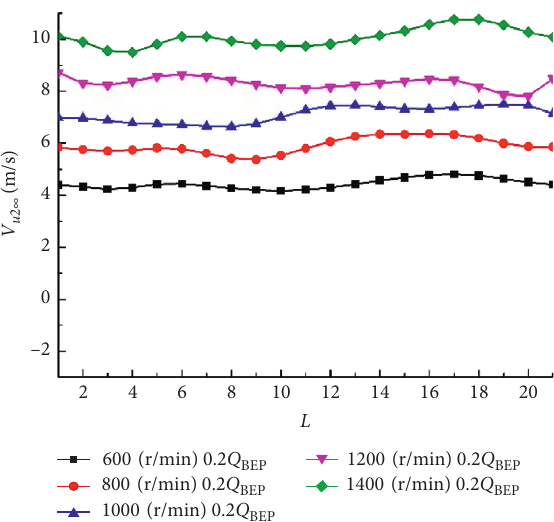
Figure 11: Circumferential component of absolute velocity with an infinite number of blades.